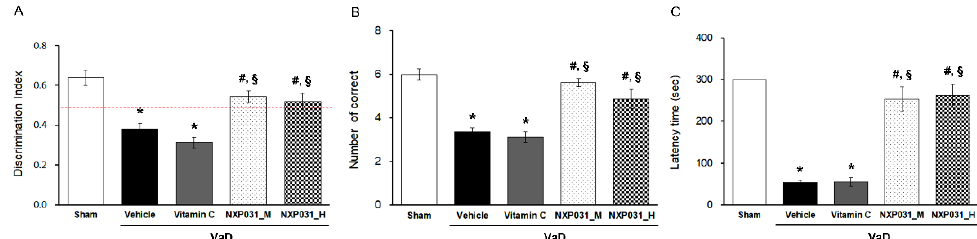
Figure 1. Effect of NXP031 on CCH-induced cognitive impairment using the NOR, radial 8-arm maze, and passive avoidance tests. ( A ) In the NOR test, rats treated with NXP031 showed significantly improved discrimination index (DI) compared to vehicle-treated rats. ( B ) In the radial 8-arm maze test, rats treated with NXP031 showed a significantly improved number of correct choices compared to vehicle-treated rats. ( C ) In the passive avoidance test, rats treated with NXP031 showed significantly increased latency times of suppression of behavior quantified on the basis of freezing compared to vehicle-treated rats. The data are presented as the mean ± S.E.M. * p < 0.05, compared with the sham group. # p < 0.05, compared with the VaD group. § p < 0.05, compared with the VaD + vitamin C group.